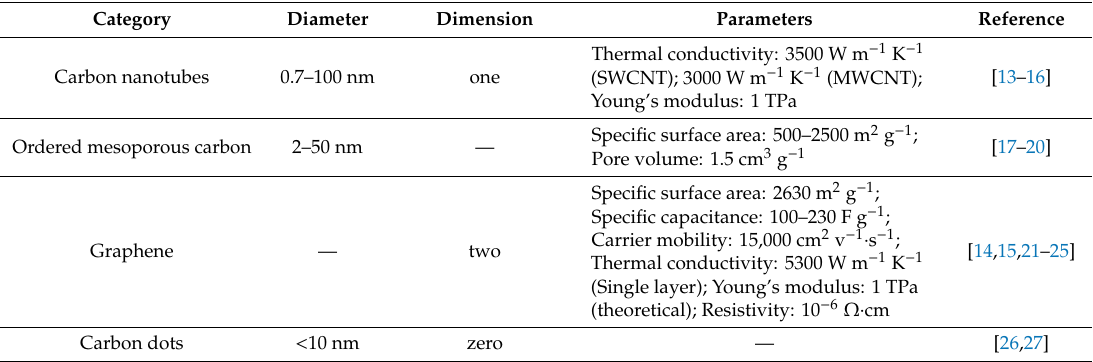
Table 1. Comparison of the characteristics of typical carbon-based